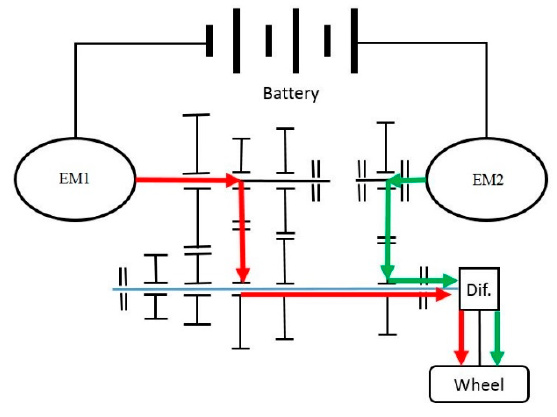
Figure 1. Dual-motor transmission.